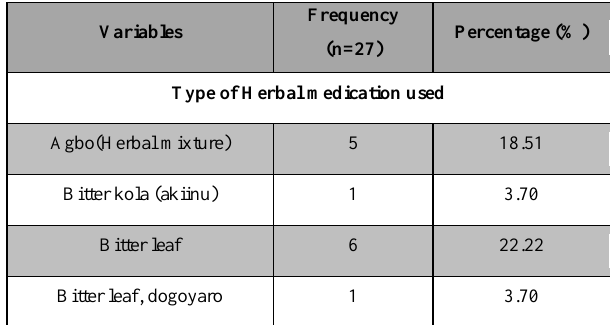
Table 3. Distribution of the types, sources of information, and the cost of procurement of Herbal medications among the study